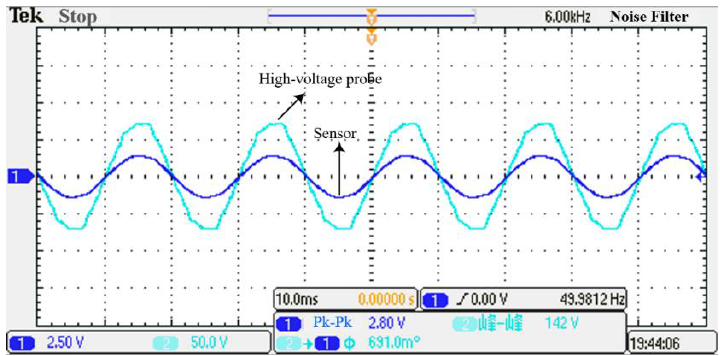
Figure 12. Steady-state measurement waveform at 5 kV.